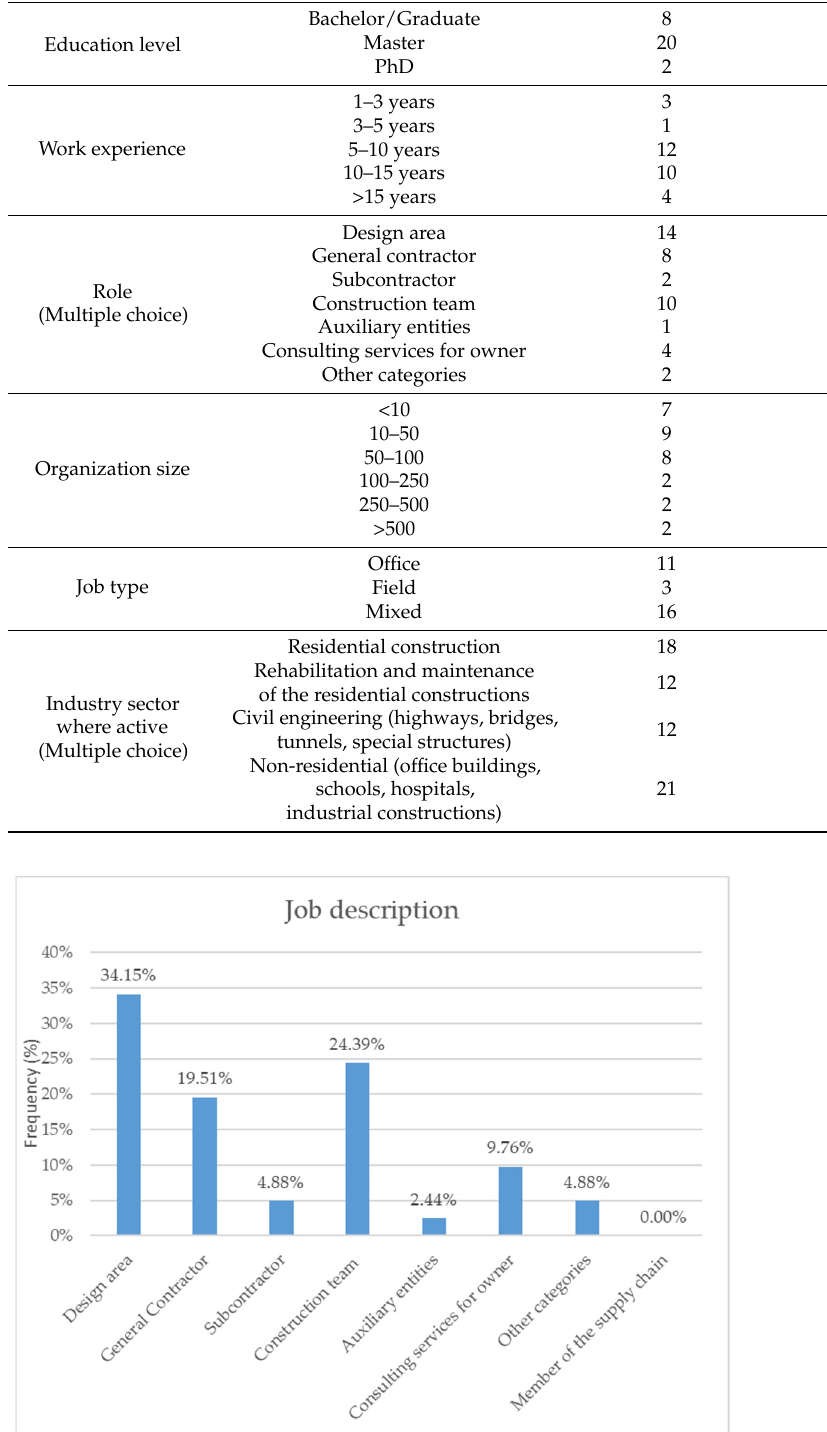
Figure 3. Activity sector of the respondents. The organization size plays an important role and is often relevant for the volume of works that a company may simultaneously enterprise. The answers to the online survey revealed that 30% of the respondents carry out their jobs in entities that have between 10 and 50 employees. Eight entries (26.67%) were recorded for companies that have between 50 and 100 workers, while micro companies represent 23.33% of the total sample. A per- centage of 6.67% represents the medium large and very large companies (100 to 250, 250 to 500, and over 500 employees). It can be noticed that the core population consists of rather small and medium-small enterprises (between 1 and 100 employees), and the greater organizations (with more than 100 workers) constitute about 20% of the analyzed sample. The answers to this question confirm the industry structure existing at the Euro- pean level; namely, that it mostly consisted of small and medium enterprises [1]. The respondent’s type of job consists mostly of mixed jobs (53.33%), followed by ex- clusively office jobs (36.67%), and in the field jobs (10%). Because the majority of the jobs have a mixed character, an increased difficulty degree in implementing the anti-COVID- 19 regulations may be noticed.